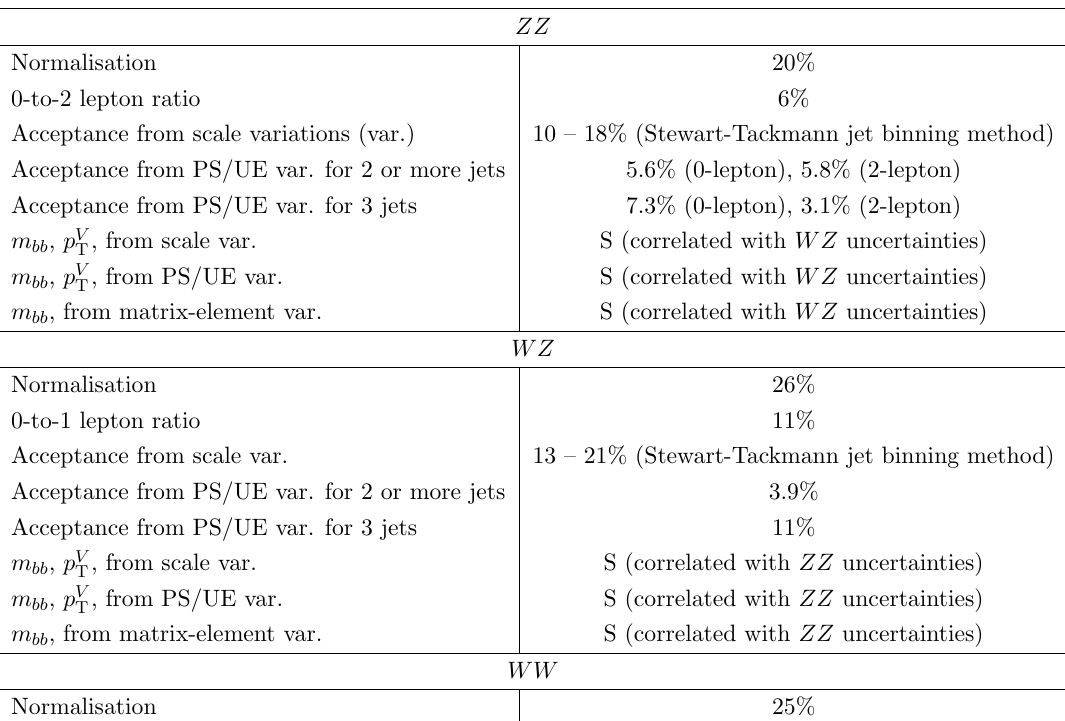
Table 7 . Summary of the systematic uncertainties in the background modelling for diboson pro- duction. \PS/UE" indicates parton shower / underlying event. An \S" symbol is used when only a shape uncertainty is assessed. When determining the ( W=Z ) Z diboson production signal strength, the normalisation uncertainties in ZZ and WZ production are